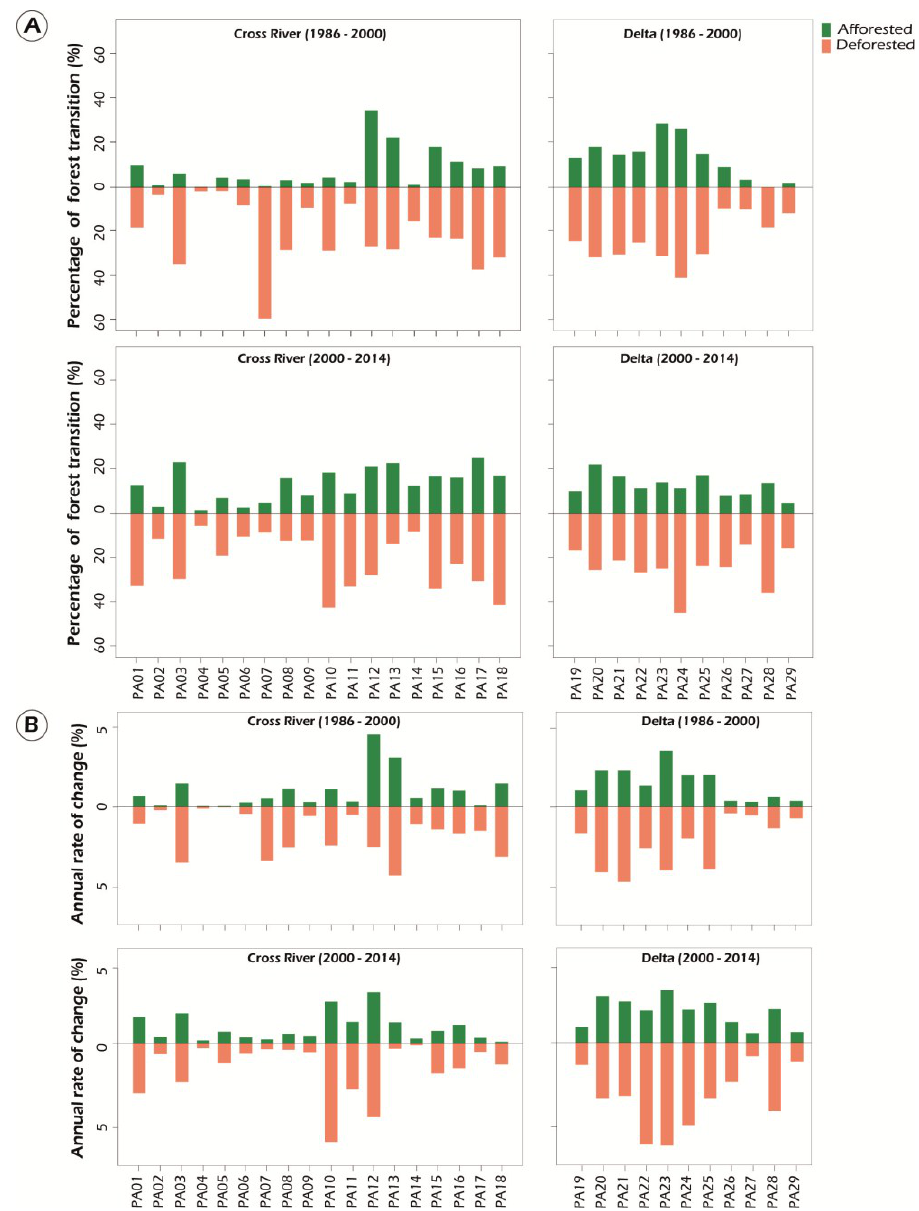
Figure 6. ( A ) Percentage of forest transition and ( B ) Average annual rates of change across protected areas in Cross River and Delta for (1986–2000) and